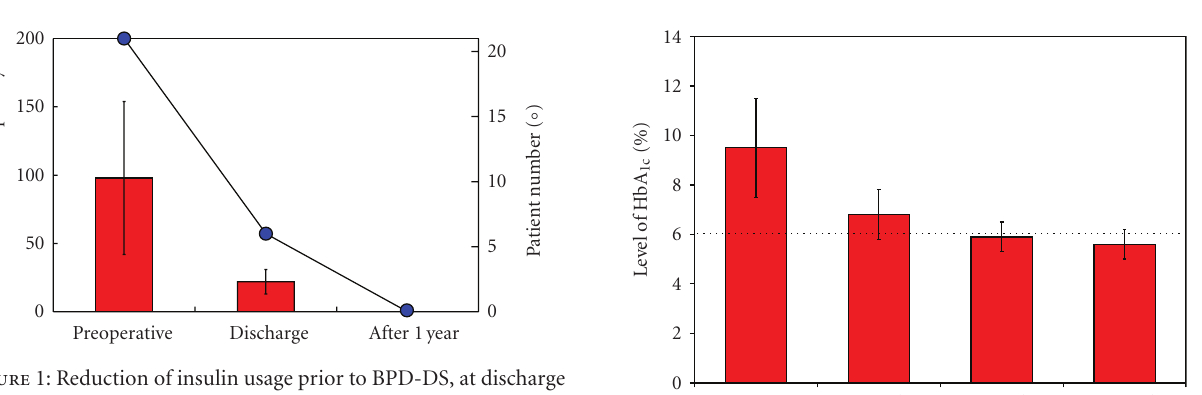
Figure 1: Reduction of insulin usage prior to BPD-DS, at discharge and one year after the operation. Blue dots indicate the number of patients in need of insulin (right scale). Red bars indicate the mean amount of insulin used per day (left scale, whiskers indicate standard deviation).